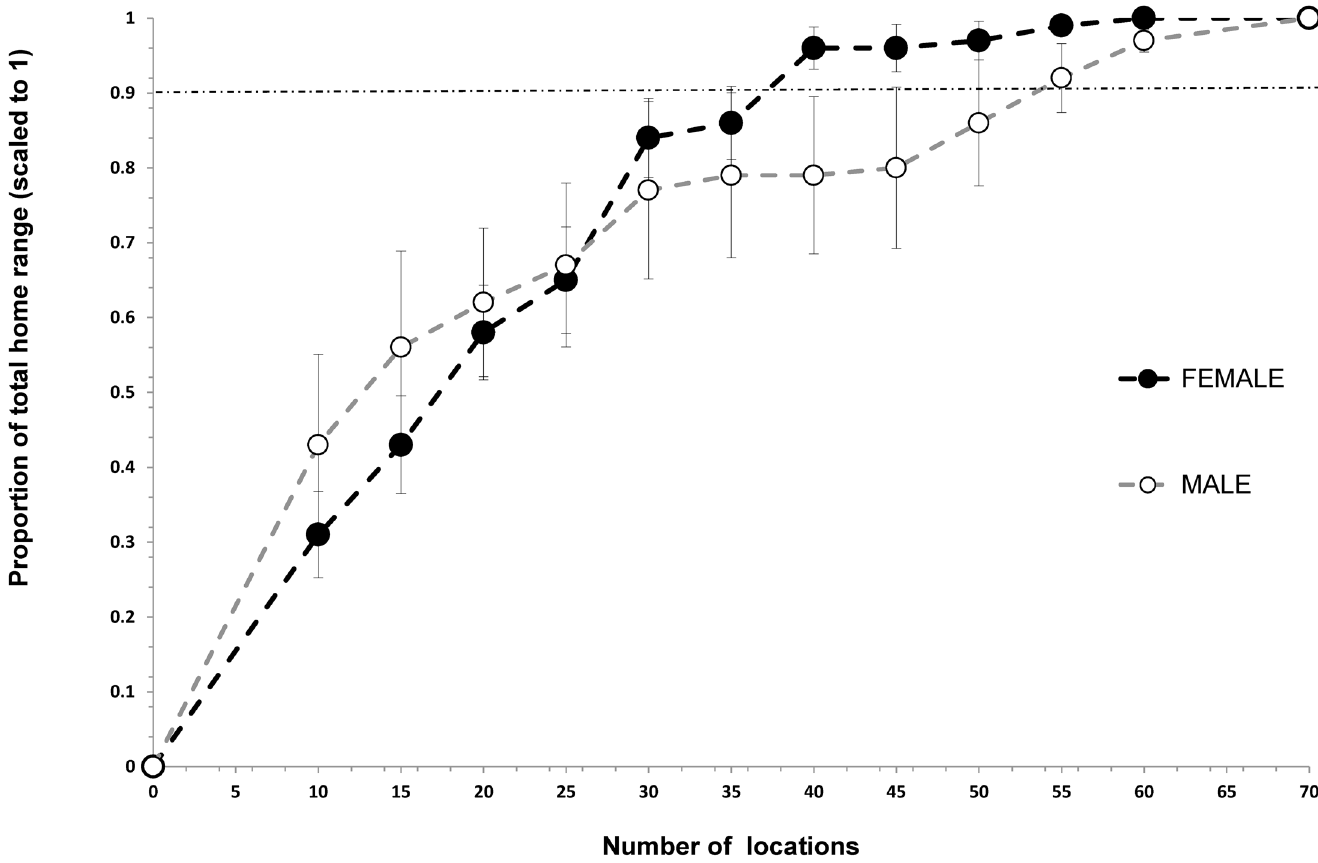
Fig 2. Incremental 95% MCP accumulation curve showing the number of locations required to more accurately estimate the annual (any consecutive 12-months) home ranges for black rhino in Hluhluwe-iMfolozi Park (HiP), South Africa. Note that the horizontal dashed line represents the within 10% level of the total home range recommended for increased